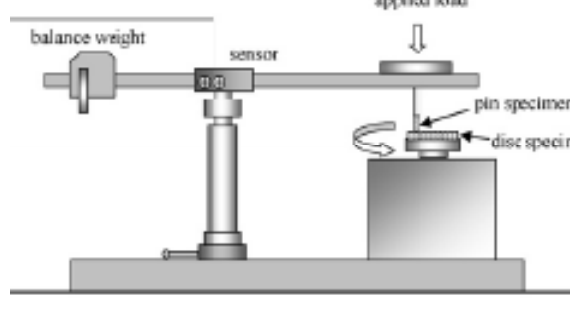
Fig. 1. A typical pin on disk test